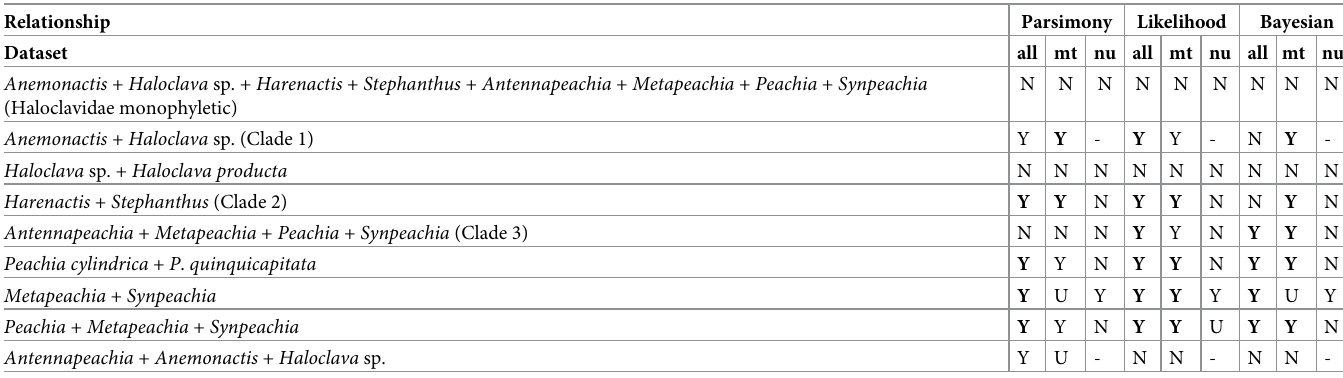
Table 1. Resolution of key relationships across each data